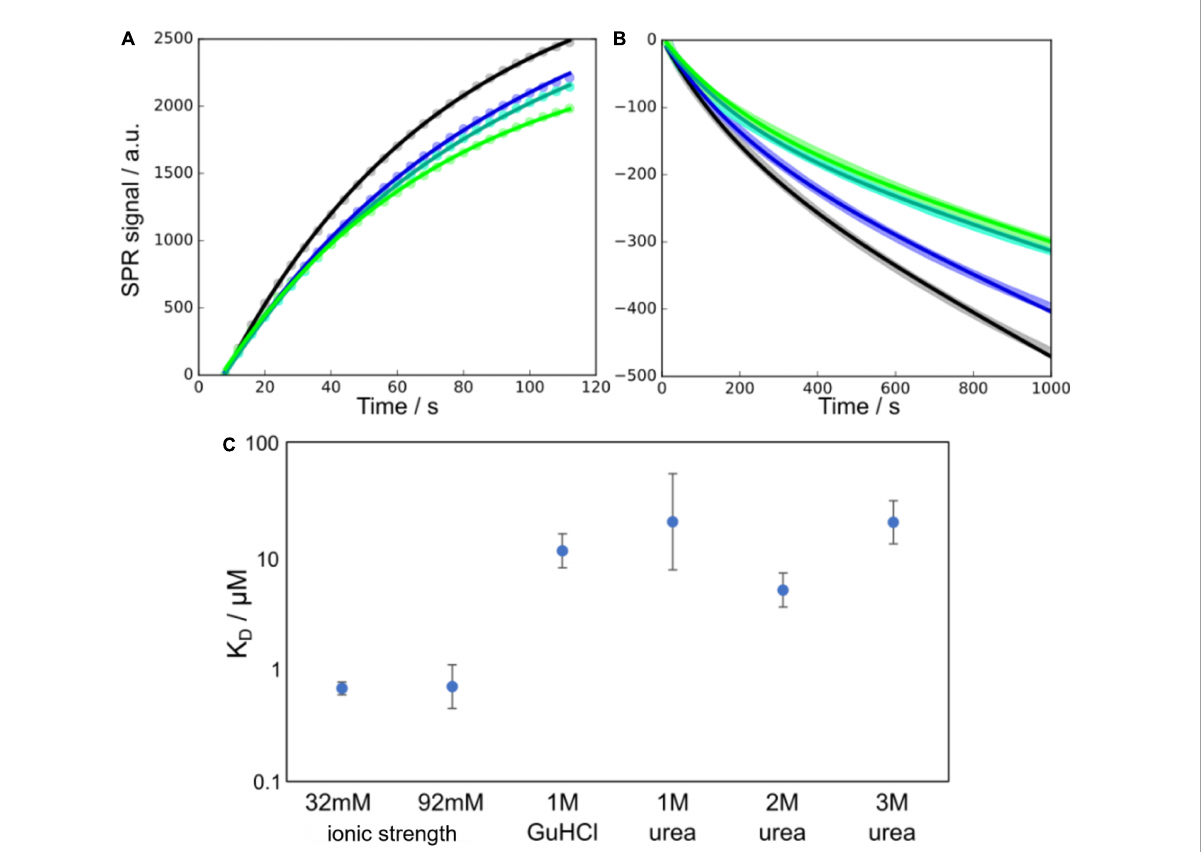
FIGURE2 Monomer binding to fibrils as measured using SPR at different denaturant conditions. (A,B) Example SPR curves (points) and fits of Equations 13, 14 (solid lines), for the association (A) and dissociation (B) parts of the SPR curves at 1 M urea and 16 µ M monomer concentration (four technical replicates). In panel (B) the data points are overlapping and appear as thick lines behind the fitted curves. (C) Affinities, in terms of the equilibrium dissociation constant K D , of monomers to the fibril surface, at a number of different denaturant concentrations. The data at 32 and 92 mM ionic strength are from Meisl et al. (2017a) and show the higher affinity in the absence of denaturant and the negligible effect that changes in ionic strength have in this range of salt